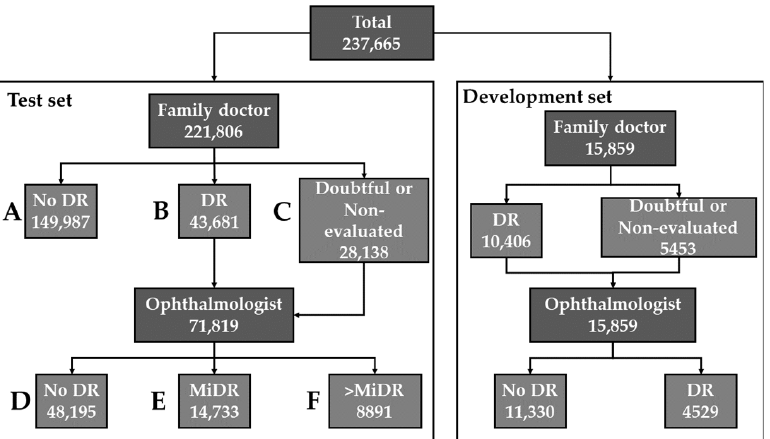
Figure 2. Distribution of visits for the screening of diabetic retinopathy (DR). Right: development set. Left: test set divided in 6 segments: A: visits evaluated only by family doctors and labeled as “no DR”. B: visits evaluated by at least one family doctor and labeled as “DR”. C: visits evaluated by at least one family doctor and labeled as doubtful or non-evaluated. D: visits evaluated by at least one ophthalmologist and labeled as “no DR”. E: visits evaluated by at least one ophthalmologist and labeled as “mild DR” (MiDR). F: visits evaluated by at least one ophthalmologist and labeled as “moderate DR” or